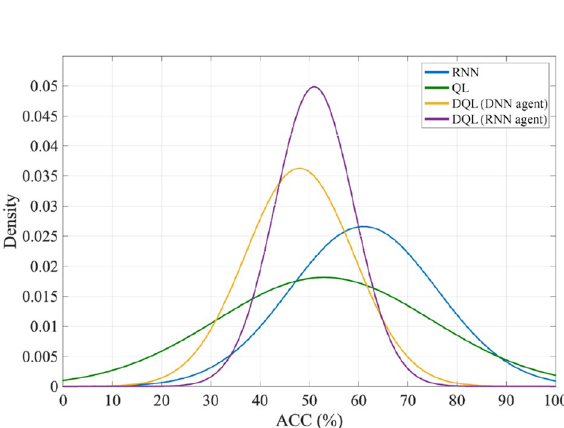
Figure 5. The results of the permutation test for different learning methods obtained for 100 repetitions of the proposed SAAD algorithm.